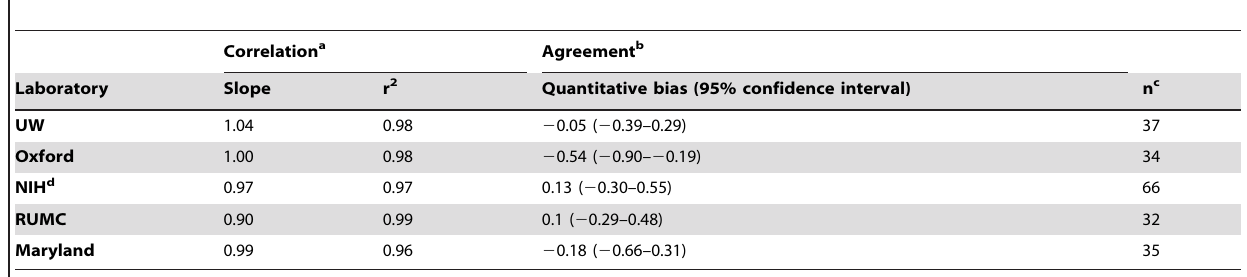
Table 3. Correlation and agreement between assay-derived data and expected